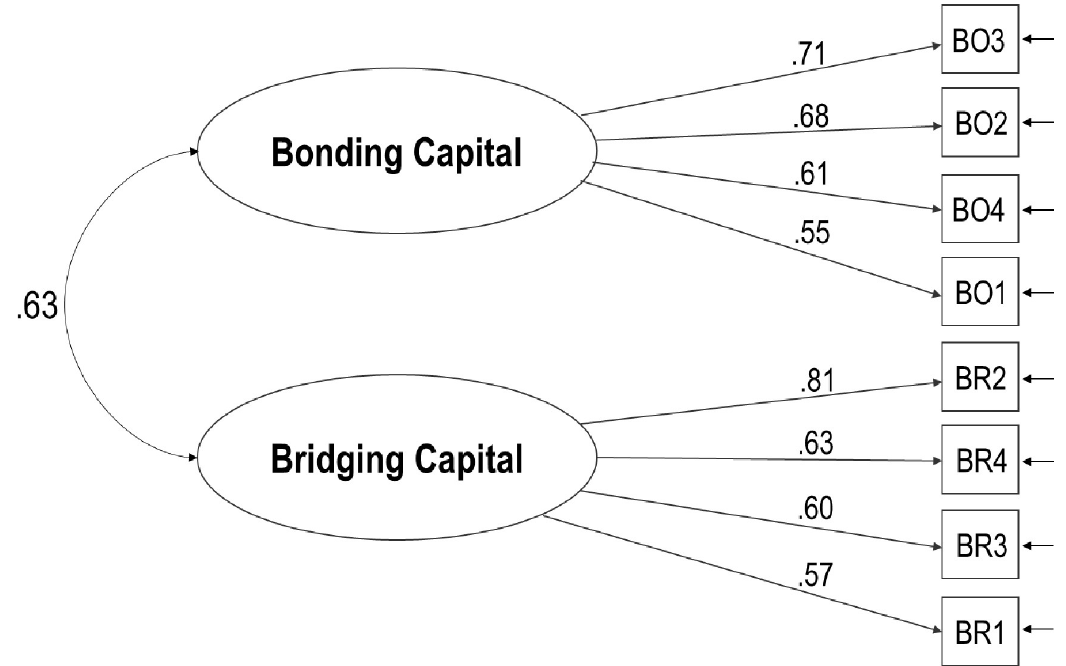
Fig 2. Confirmatory factor model of the 2-factor model of the personal on-offline social capital brief scale.